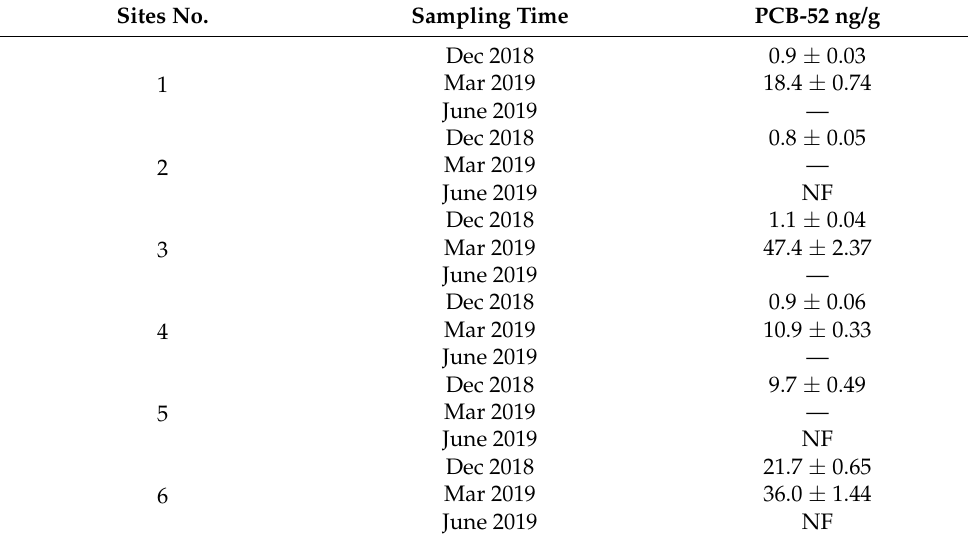
Table 5. Distribution characteristics of PCBs in surface sediments in water sources. Sites